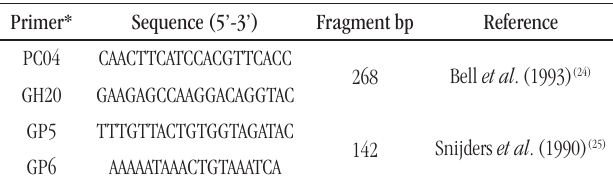
taBLE 1 − Primer pair DNA